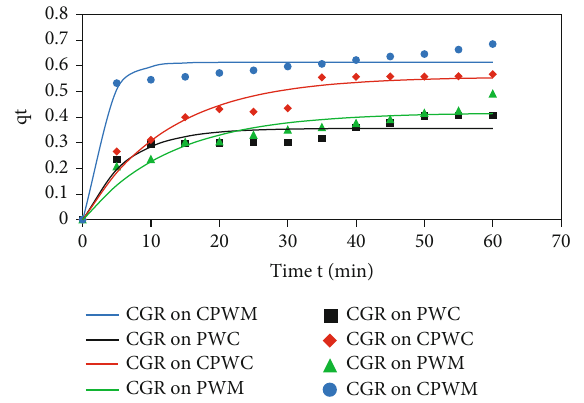
Figure 18: Nonlinear pseudo second-order kinetic